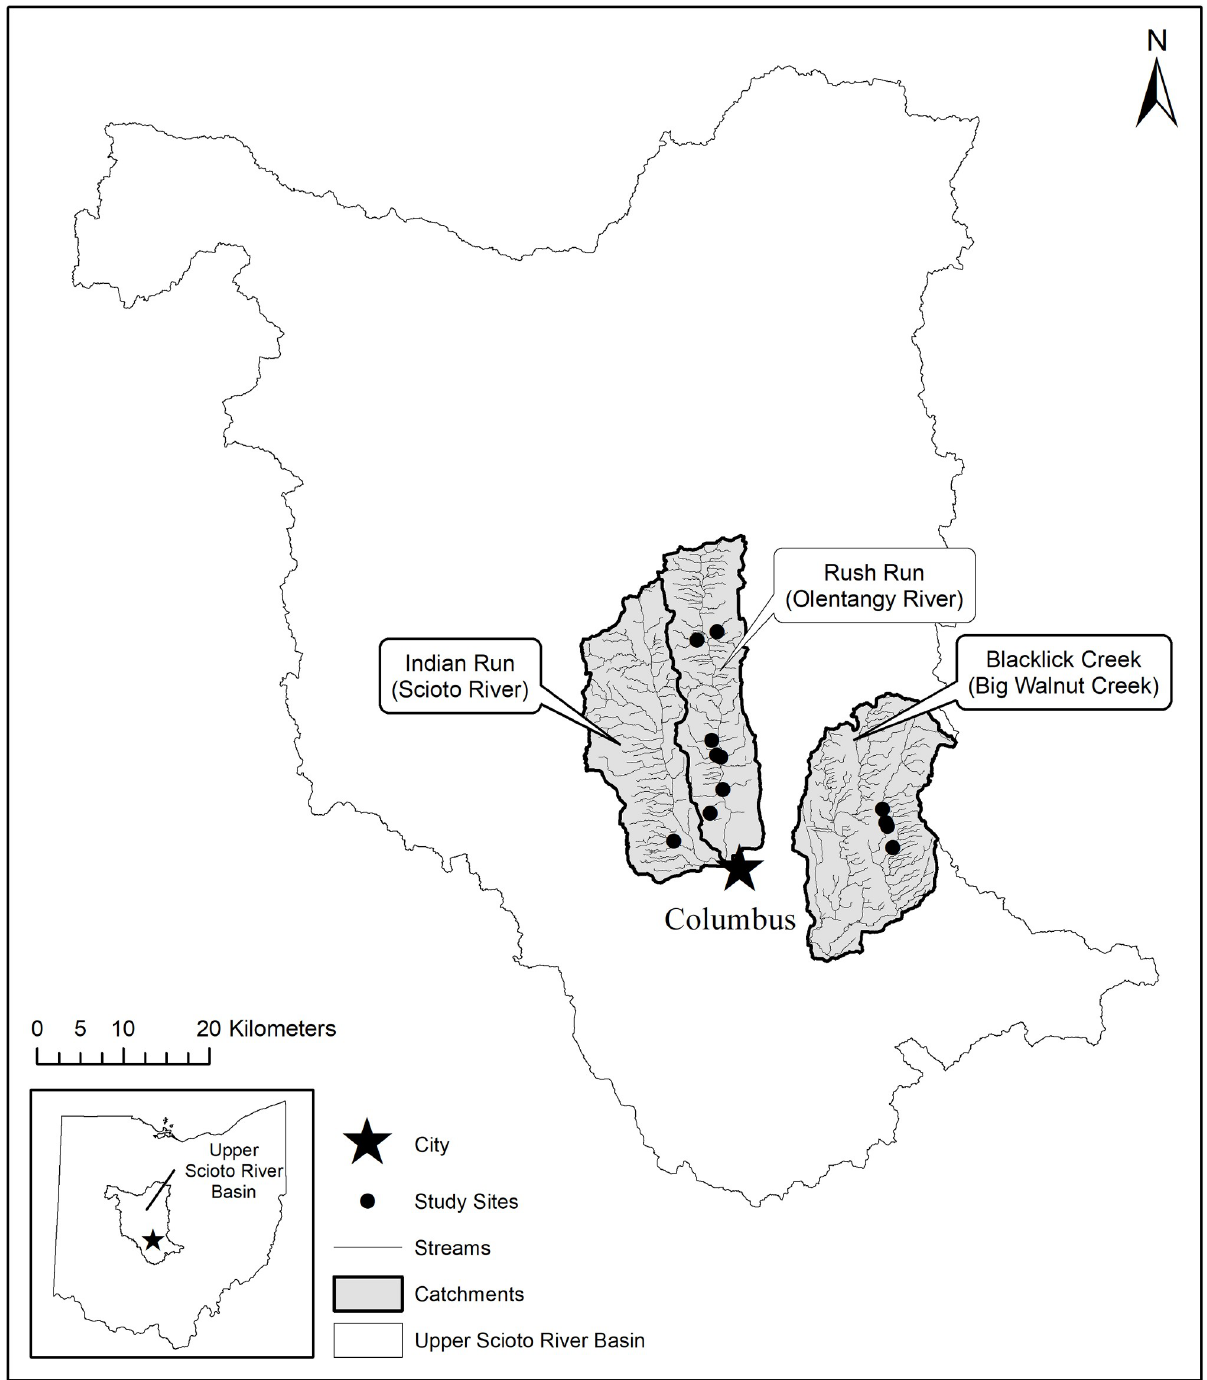
Fig 2. Map of study reach locations. Study reach locations (black dots) within major sub-catchments of the upper Scioto River basin. City center of Columbus, Ohio shown for reference.